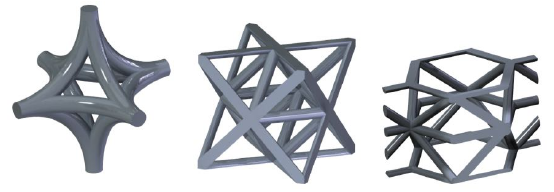
Figure 14. Lattice structure base elements: nonlinear thrust structure, octet structuer, hex structure (left to right)